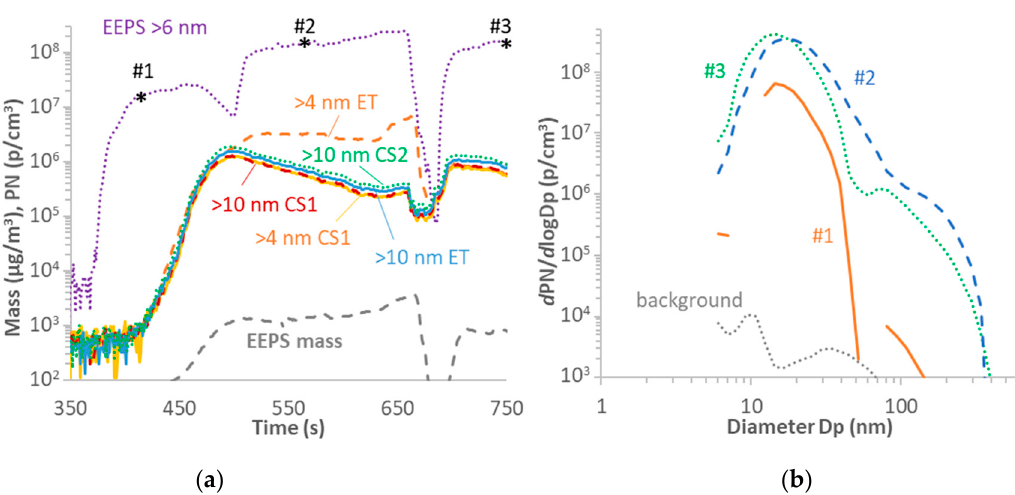
Figure 6. Particle number (PN) emissions during the second regeneration event at 100 km/h: ( a ) Total (i.e., including volatiles) measured with the EEPS and nonvolatile particles with the rest instruments using evaporation tube (ET) or catalytic strippers (CS). The estimated mass from EEPS is also plotted; ( b ) size distributions of total PN for the times indicated in panel (a).